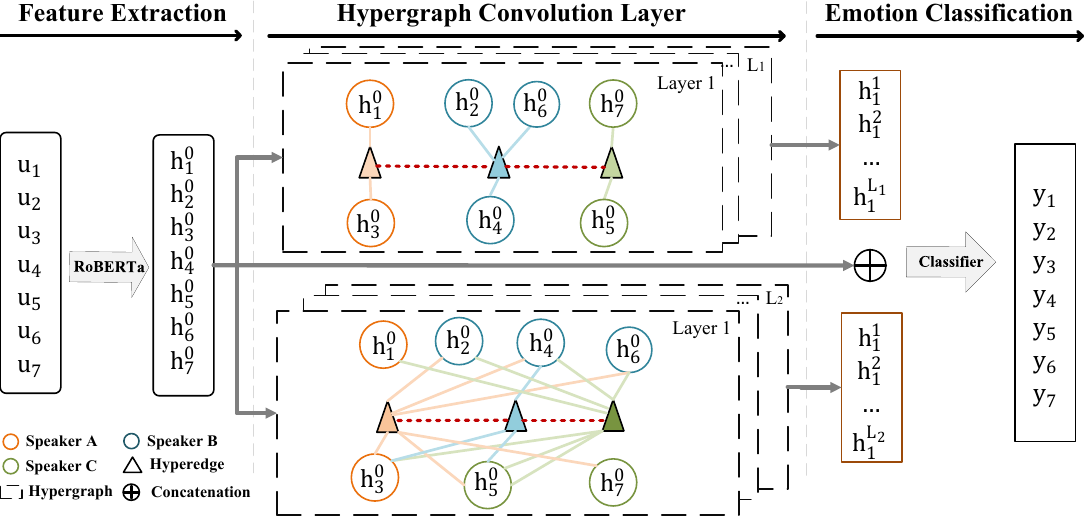
Figure 2. Overview of our proposed model. In the hypergraph convolutional layer module, the red dotted line represents the information transfer between the